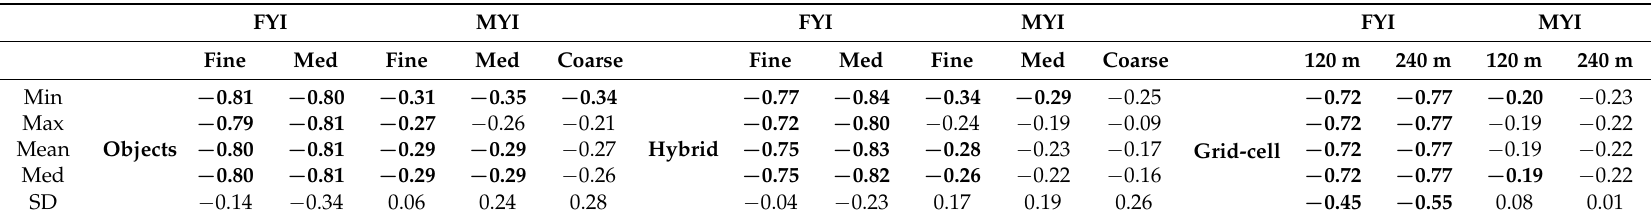
Table 4. Spearman correlation coefficients (r s ) between metrics of smoothed winter sea ice roughness and f p for FYI and MYI at fine, medium (med) and coarse spatial scales. The data were aggregated using the hybrid object aggregation approach. Bolded values are statistically significant ( p <